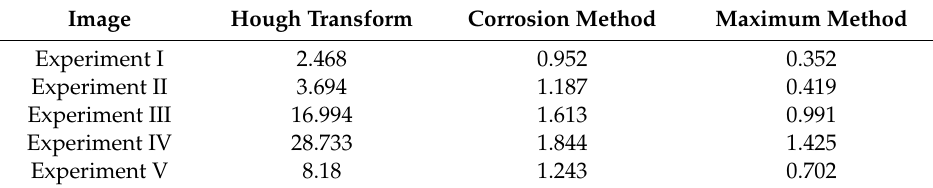
Table 3. Runtime of the three methods.